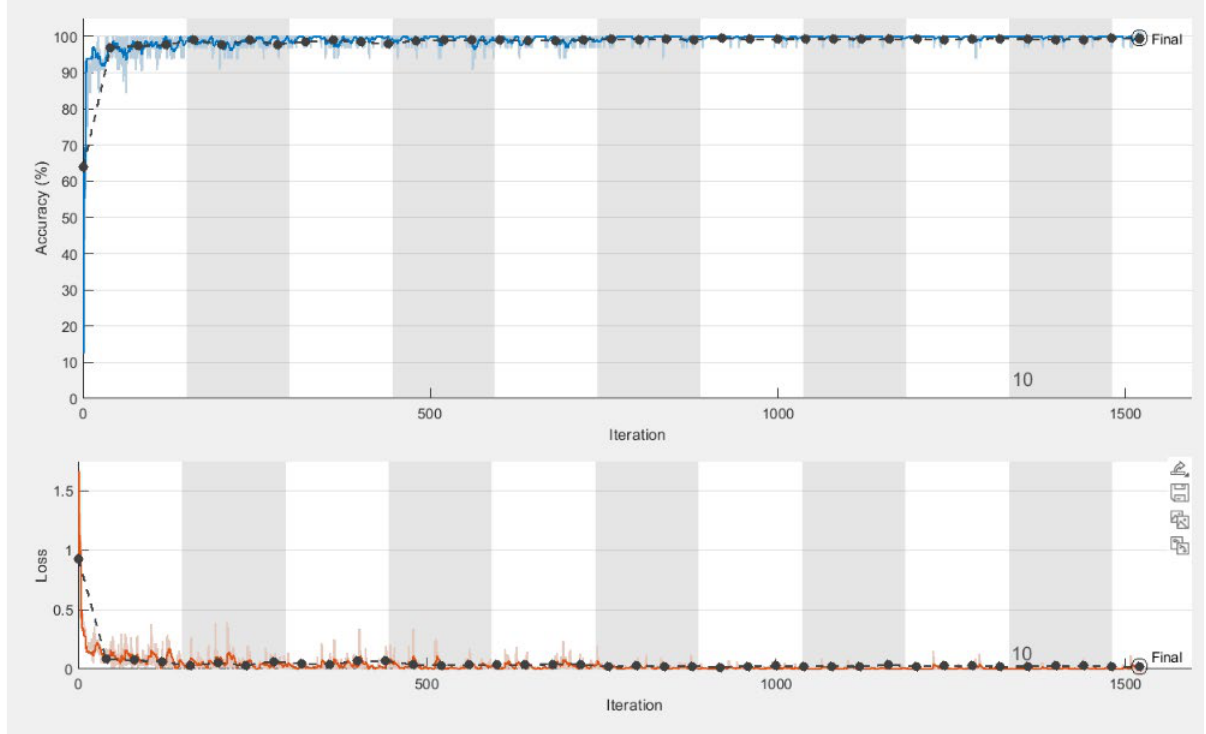
Figure 5. The plots for convergence of accuracy ( upper graphic) and loss-( bottom graphic) for both training (in light blue for accuracy and in orange for loss) and validation (dotted).